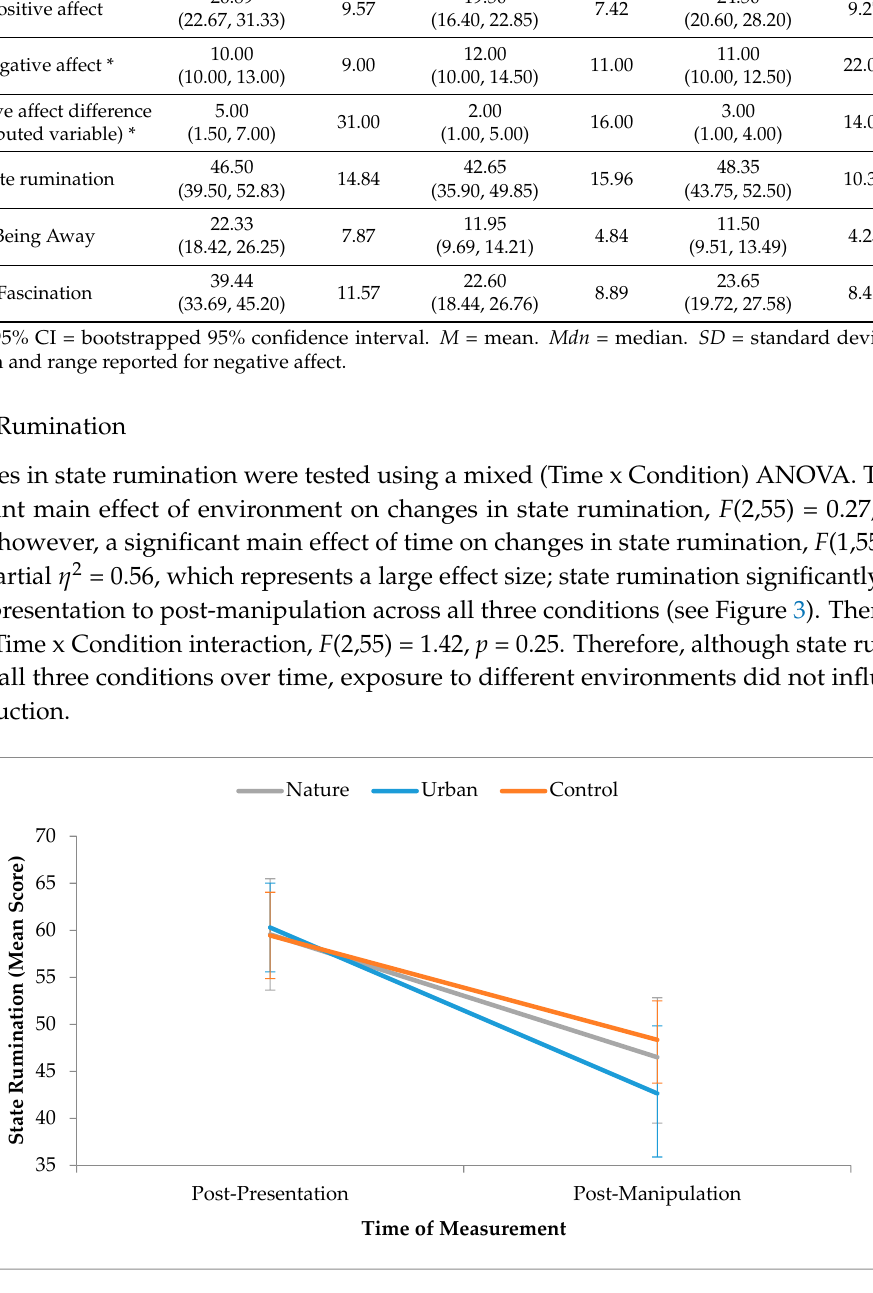
Table 5. Descriptive Statistics at Post-Manipulation by Condition.